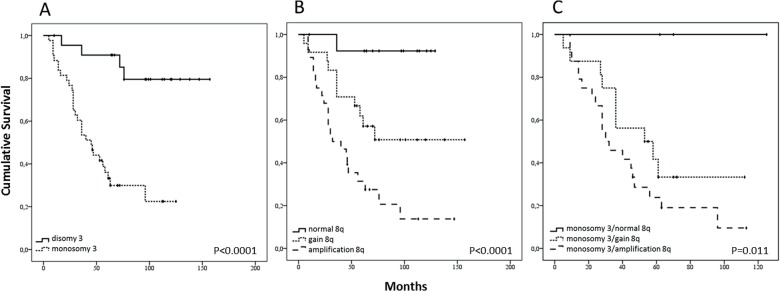
Worst survival for patients with amplification of chromosome 8q.The presence of monosomy 3 (n = 43) in UM is highly prognostic for death due to metastases compared to the presence of disomy 3 (n = 23) (p<0.0001). (A) Significant differences in survival between classes of tumours with normal (n = 14), gain (n = 24), or amplification (n = 28) of chromosome 8q. A significant difference in survival was observed between the three categories (p<0.0001), and between the different individual classes: normal vs. amplification (p<0.0001), and gain vs. amplification (p = 0.00125). Between normal and gain of 8q a trend towards significance was observed (p = 0.07). (B) On the background of monosomy 3, 8q amplification (n = 24) increased the risk significantly (p = 0.011) compared to monosomy 3 with 8q gain (n = 16). Three UM presented monosomy 3 without aberration on 8q: none died due to UM metastasis. (C)